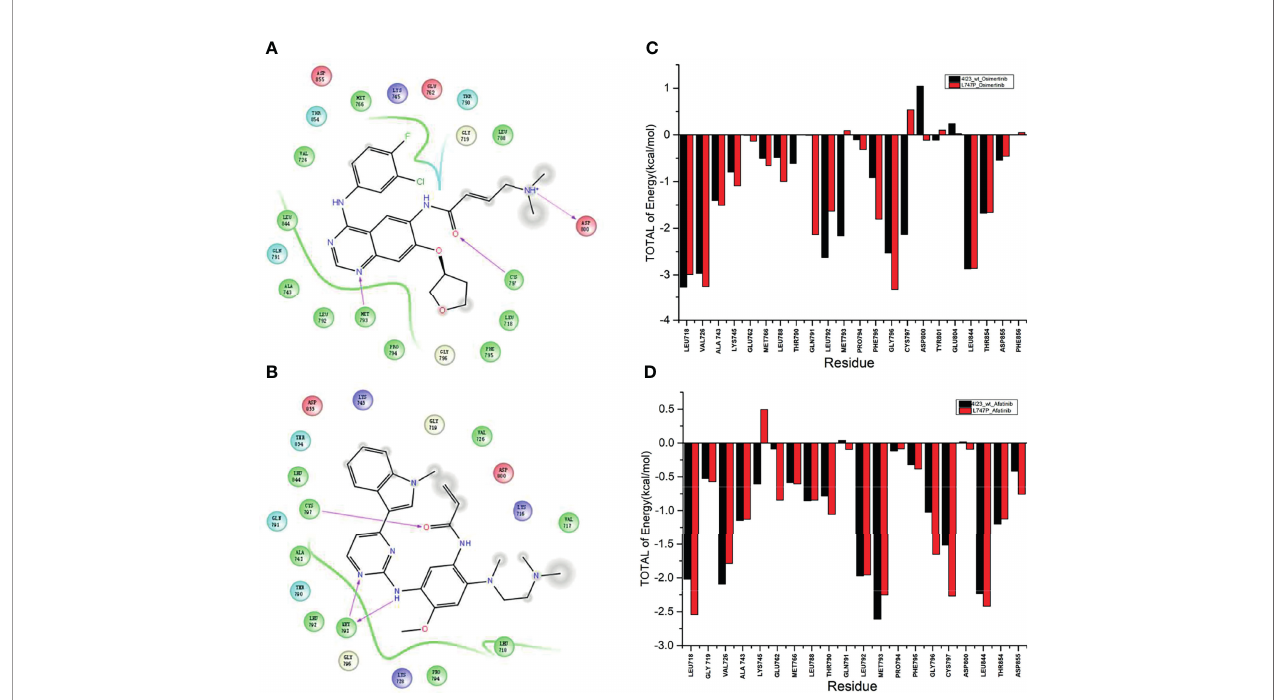
FIGURE 2 | Key amino acid residues binding with molecules in the wild type of EGFR kinase domain with afatinib (A) and osimertinib (B) . Binding free energy with osimertinib (C) and afatinib (D) in EGFR wild type and p.L747P conformation.